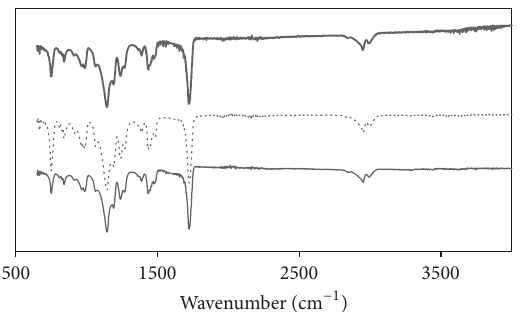
Figure 3: FTIR spectra of pure PMMA (thin line), CoNPs/PMMA composites (dotted line), and DBSA-CoNPs/PMMA composites (thick line).